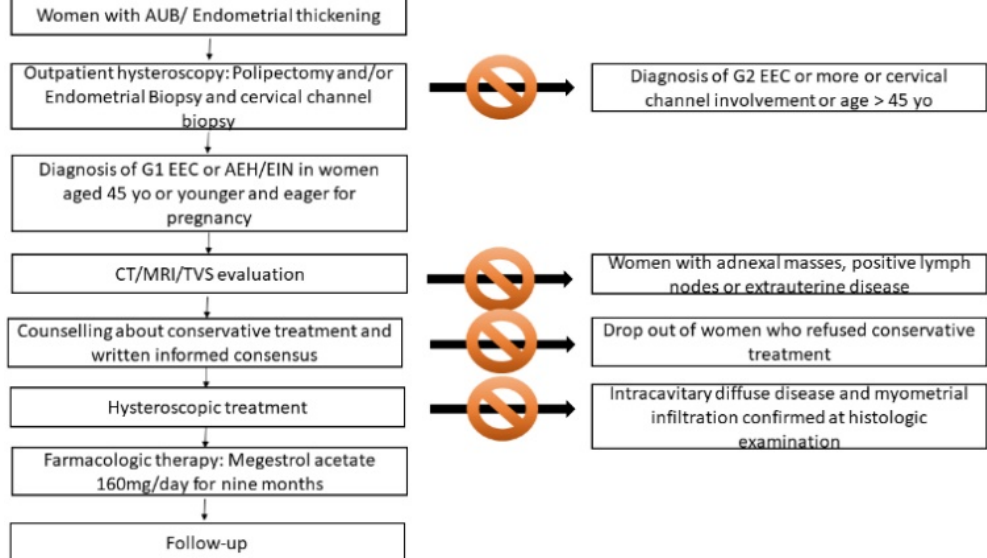
Figure 2. Flowchart of our diagnostic and therapeutic approach of women with G1 EEC and AEH/EIN candidate to fertility sparing treatment.